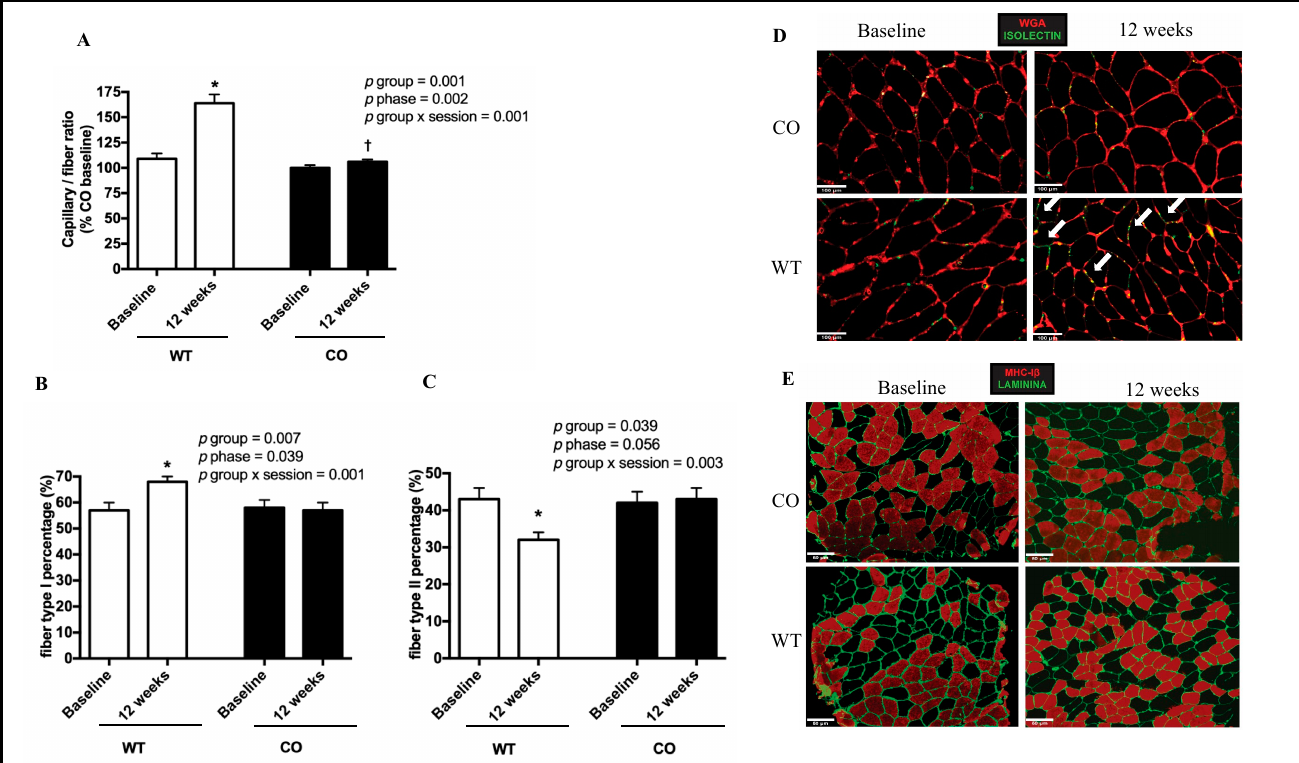
Figure 2. Muscle capillary-fiber ratio and percentage of muscle fiber types I and II assessed at baseline and after 12 weeks in the control (CO; n = 8) and walking training (WT; n = 8) groups. ( A – C ) present mean ± SE values. ( D , E ) show, respectively, representative figures of muscle capillary-fiber ratios and muscle fiber type percentages. White arrows indicate an increase in capillaries, * denotes a difference from the baseline within the group ( p < 0.05), † denotes a difference from WT at 12 weeks ( p < 0.05). Muscle expression of miRNA-126 increased for the WT group and decreased for the CO group following the interventions (WT = 101 ± 13 vs. 130 ± 5 and CO = 100 ± 14 vs. 77 ± 20%, p < 0.001; Figure 3A). VEGF increased for the WT group only (WT = 103 ± 28 vs. 153 ± 59 and CO = 100 ± 36 vs. 84 ± 41%, p = 0.001; Figure 3B), while muscle SPRED-1 expression showed no significant change statistically for both groups (WT = 98 ± 35 vs. 109 ± 25 and CO = 100 ± 34 vs. 104 ± 32%, p = 0.519, Figure 3C). In contrast, muscle PI3KR2 expression decreased (WT = 97 ± 23 vs. 75 ± 21 and CO = 100 ± 29 vs. 105 ± 39%, p = 0.021, Figure 3D) only for the WT